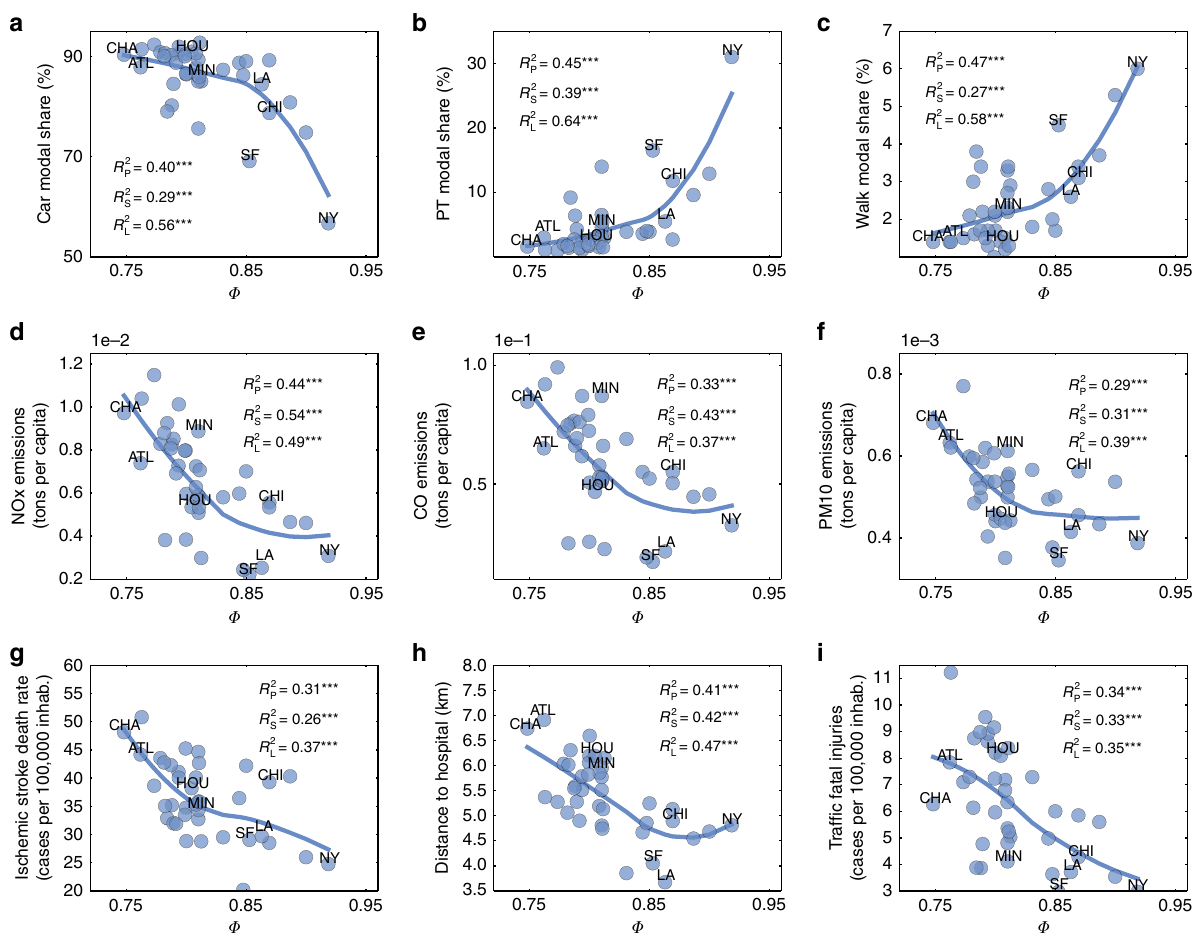
Fig. 4 Connecting Φ with urban indicators in US cities. a – c Modal share for trips to work (%) as a function of Φ in US cities: a Modal share by private car, b by public transportation (PT) and c by walking. d – f Relation between Φ and pollutant emissions: d NO X , e CO and f PM10 in metric tons per capita. g – i Connecting Φ and health: g ischemic stroke mortality per 100,000 inhabitants, h average distance to closest hospital and i incidence of traf fi c fatalities per 100,000 residents. Correlations are measured using Pearson, Spearman, and LOESS with the corresponding explained variances denoted as R 2 R 2 , (details in Supplementary Note 9). Asterisks correspond to signi fi cance-level (p value) of regressions (one * is less than 0.05, two less than 0.01, and L three less than 0.001). Some city names appear in the plots: ATL (Atlanta), CHA (Charlotte), CHI (Chicago), HOU (Houston), LA (Los Angeles),